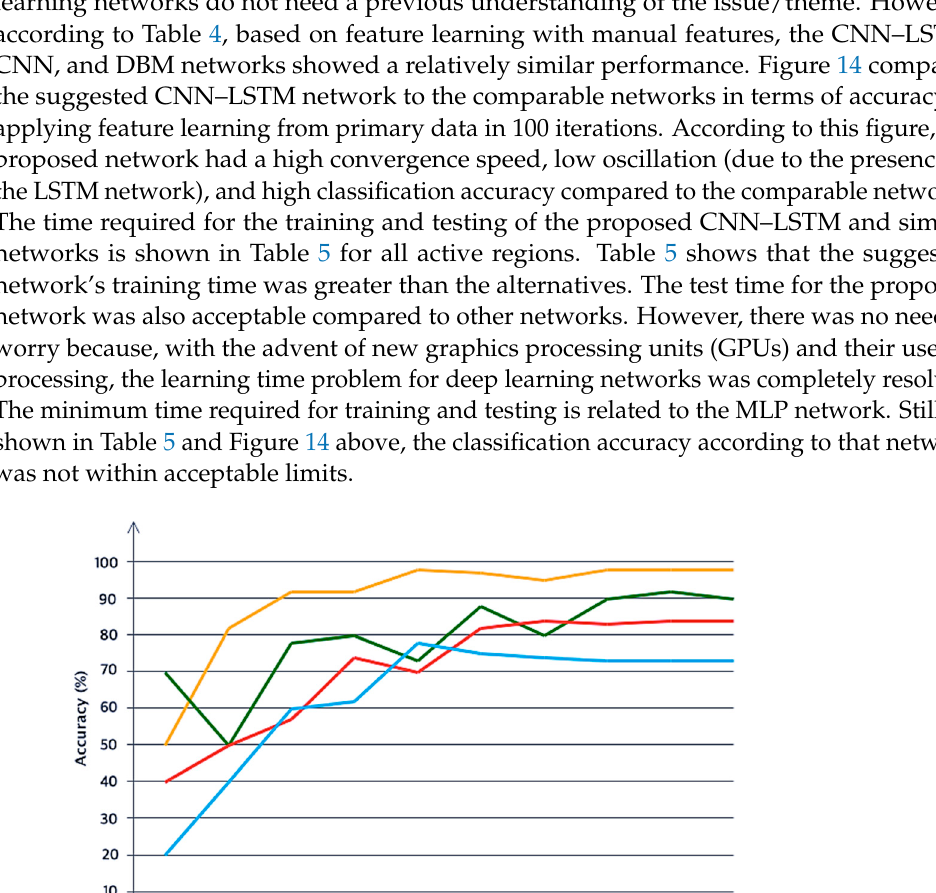
Table 4. Classification accuracy of the suggested method compared with other methods of compar- ison.